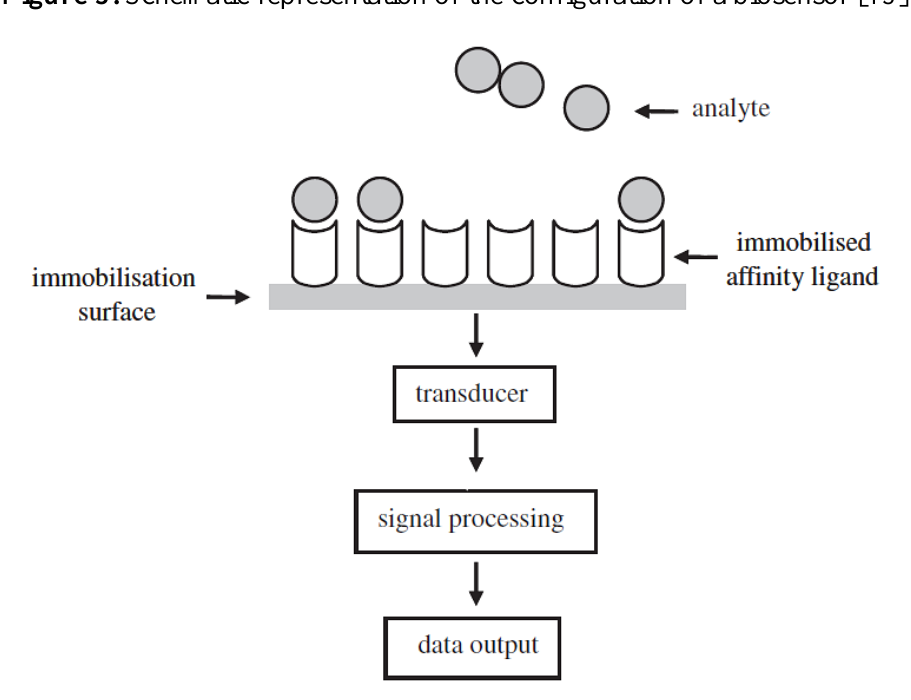
Figure 3. Schematic representation of the configuration of a biosensor